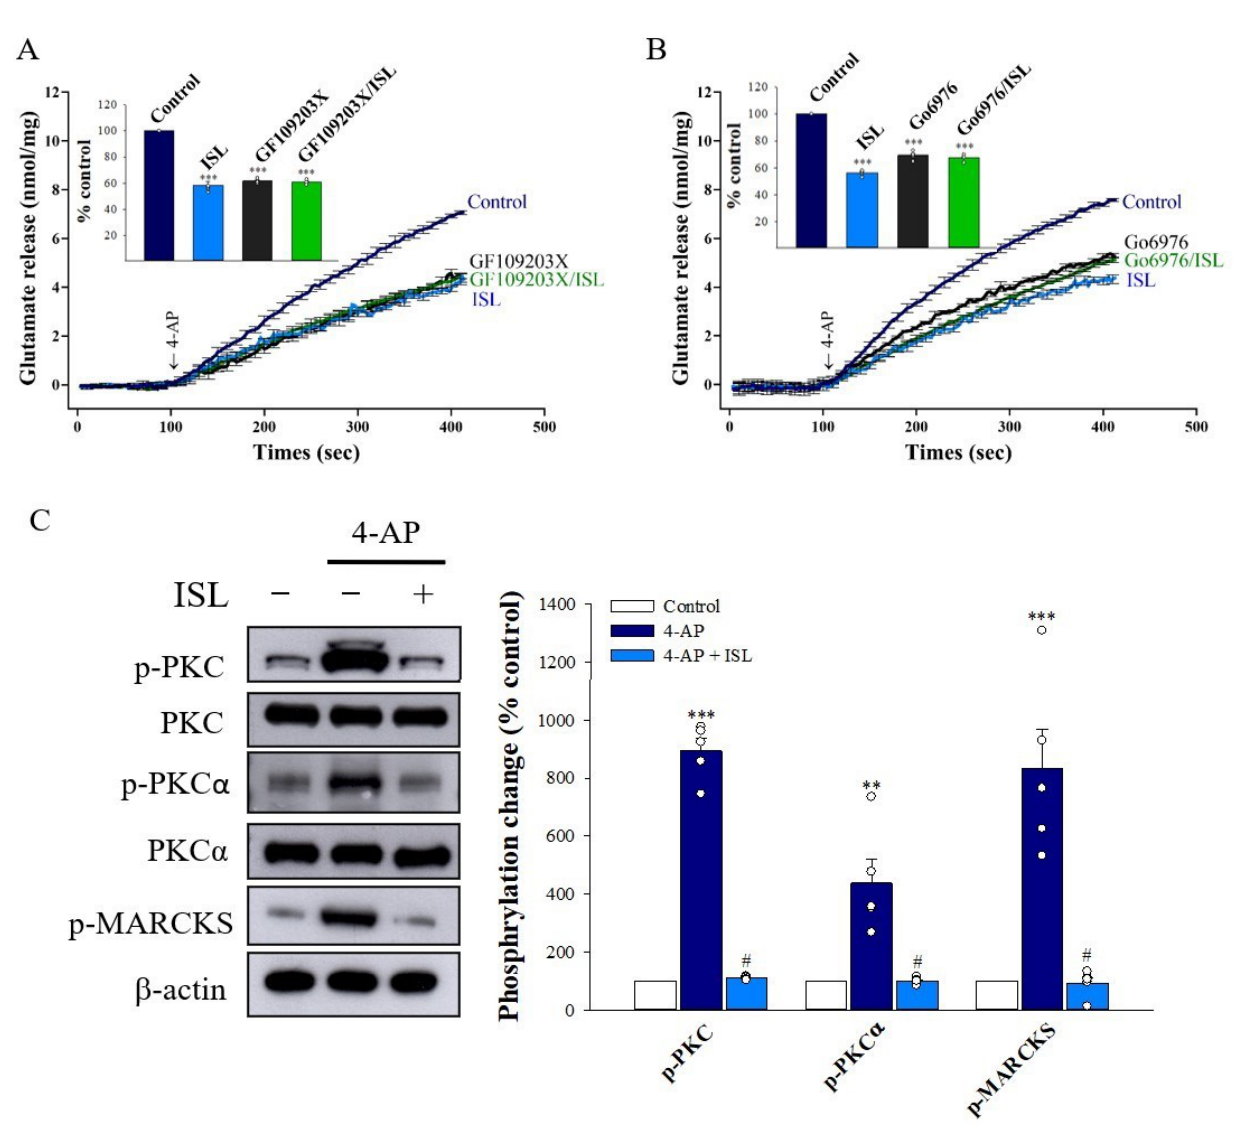
Figure 3. Involvement of PKC suppression in the inhibition caused by ISL on glutamate release. ( A ) 4-AP-evoked glutamate release from synaptosomes incubated in the absence (control) or presence of 10 µ M ISL, 10 µ M GF109203X, or both ( A ); or 10 µ M ISL, 1 µ M Go6976, or both ( B ). Insets ( A , B ) compare the effects of PKC inhibitors on 4-AP-evoked glutamate release, or the inhibition by ISL (% control release 5 min after 4-AP addition). ( C ) 4-AP-indued phosphorylation of PKC and MARCKS was detected in the absence ( − ) or presence (+) of 10 µ M ISL. The quantification of PKC or MARCKS phosphorylation was normalized to β -actin. Data are the mean ± SEM (n = 5 per group). ***, p < 0.001 versus the control group; **, p < 0.01 versus the control group; #, p < 0.05 versus the 4-AP-treated group.